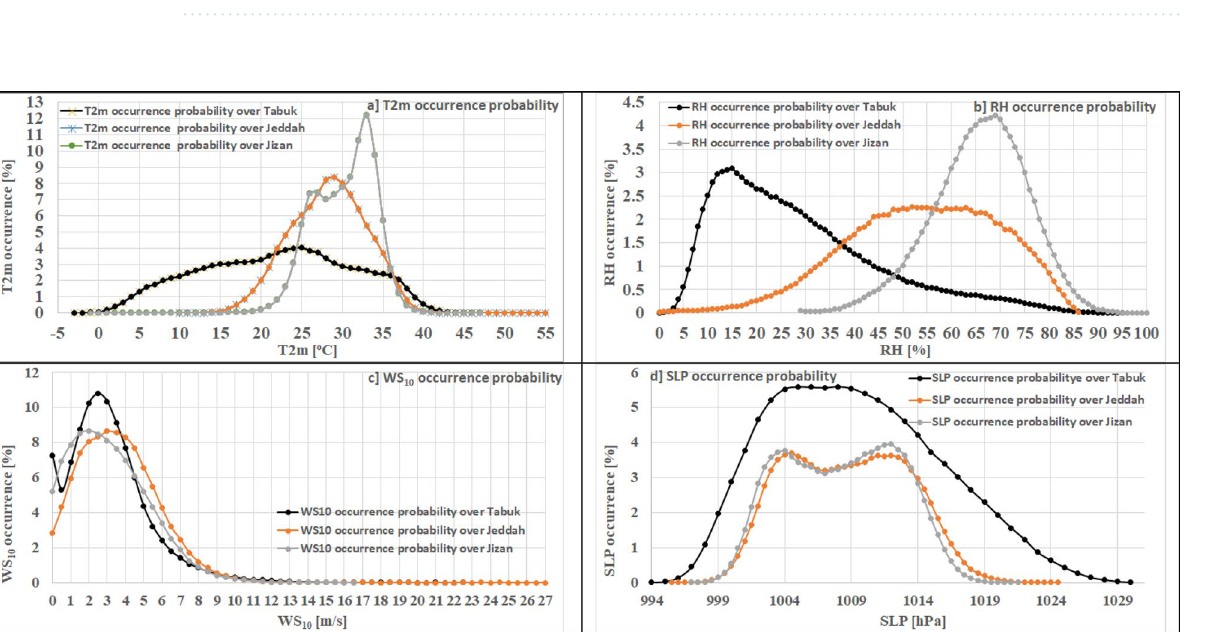
Table 3. Long-term annual mean and trend analyses of the corrected ERA5 weather variables in Tabuk, Jeddah and Jizan from 1979 to 2020. The nonparametric Mann–Kendall test is used to detect monotonic trends in the corrected ERA5 data to examine whether the C_ERA5 data follow a significant (monotonic) trend.